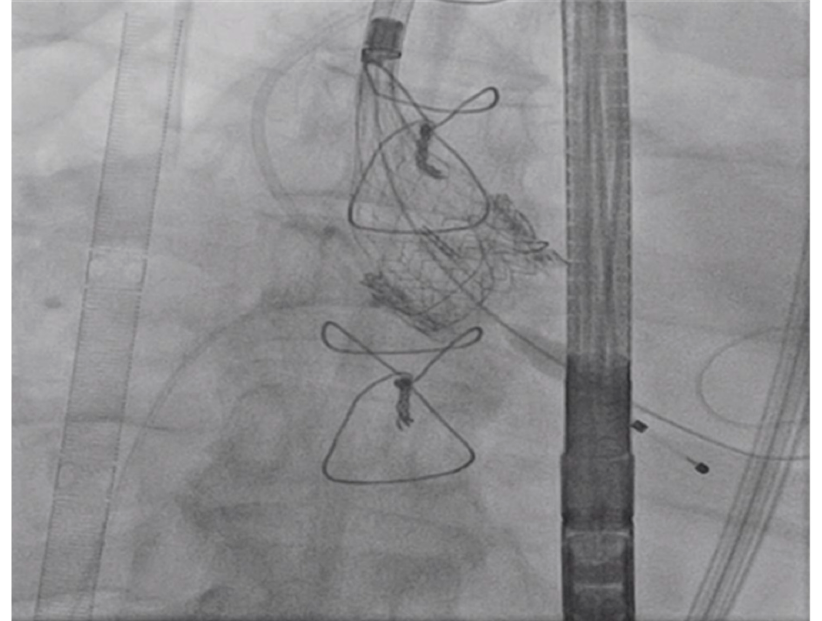
Figure 4. Left Anterior Oblique (LAO) Caudal View: Valve being deployed while transvenous pacemaker in place.